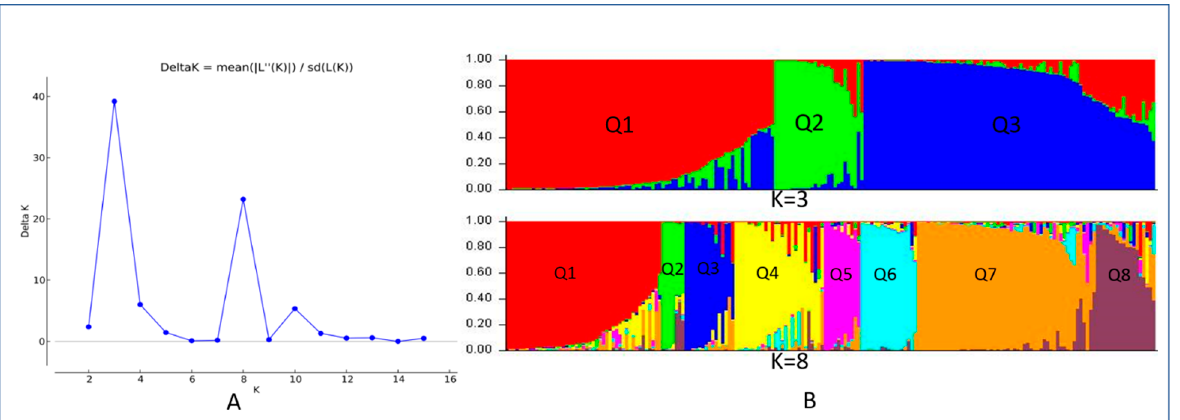
Figure 1. ( A ) Delta K values for different numbers of populations assumed (K) in the STRUCTURE analysis. ( B ) Classification of 196 accessions into three “Q populations” (K = 3) or eight “q populations” (K = 8) using STRUCTURE 2.3.1. The distribution of the accessions to different populations is indicated by the color code. Numbers on the y -axis show the subgroup membership, and the x -axis shows the different accession.